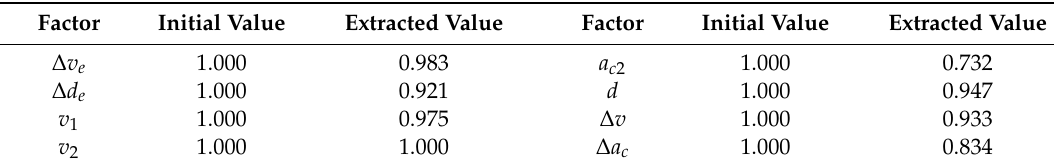
Table 3. Common factor variance.